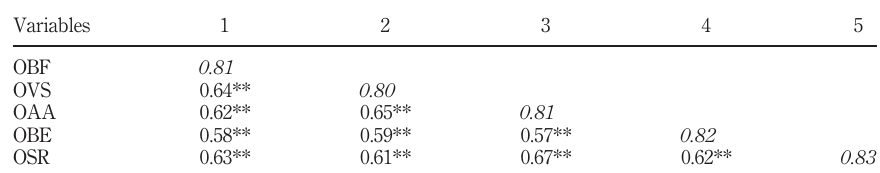
Table III. Discriminant analysis of fi ve factors and model fi